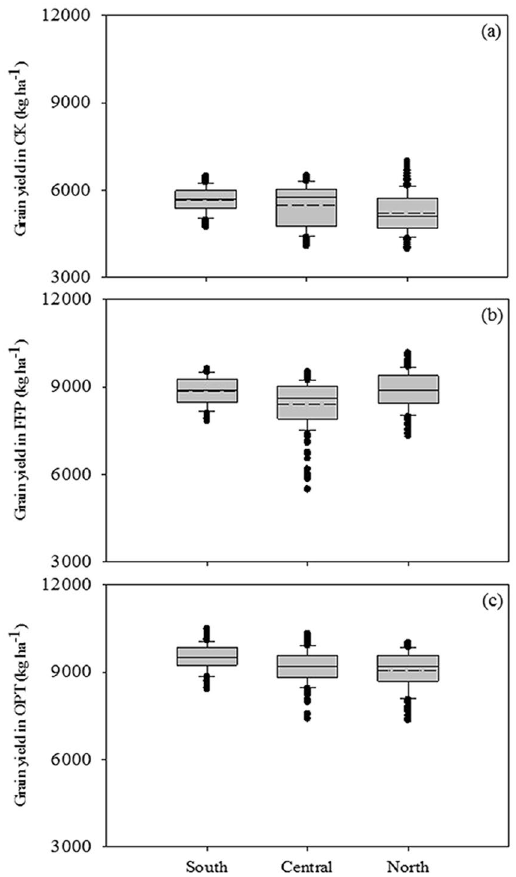
Figure 3. Rice grain yield of large demonstration areas on free-N control (CK, a ), farmers’ fertilizer practices (FFP, b ) and optimized N managements (OPT, c ) in south, central and north Jiangsu in